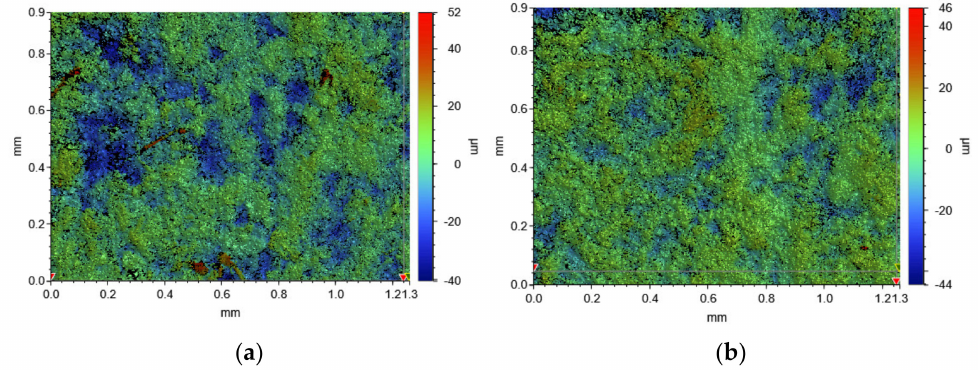
Figure 13. White light interferogram of A ( a ) and B ( b